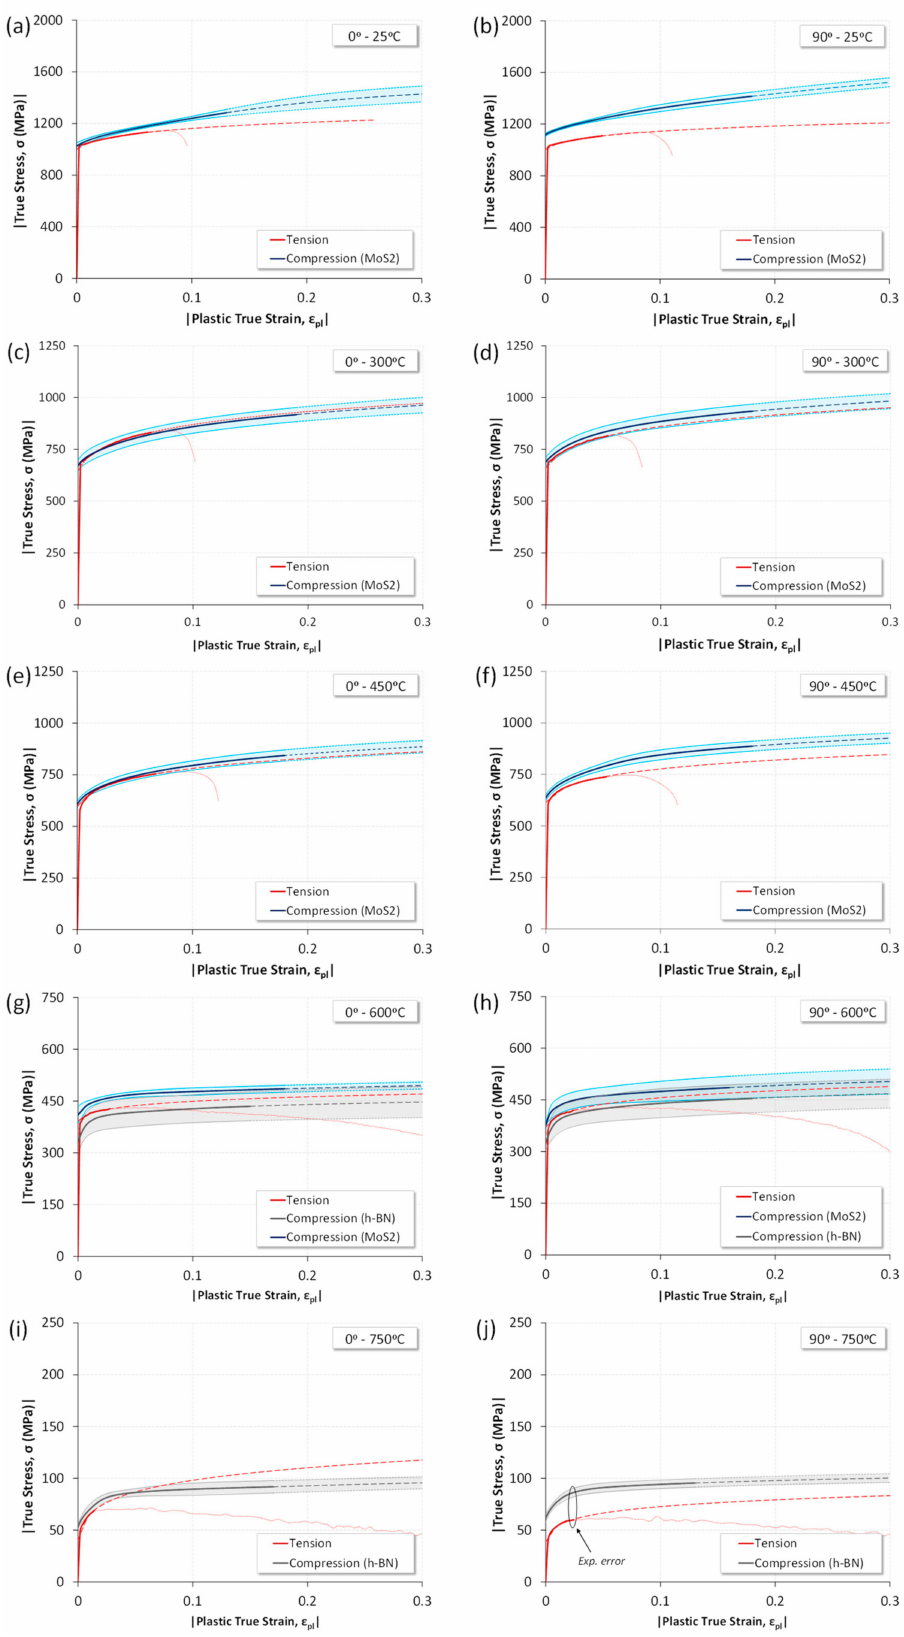
Figure 9. Tension and compression behavior of Ti6Al4V at 0.002 s − 1 and temperatures of 25, 300, 450, 600, and 750 ◦ C. ( a , c , e , g , i ) Mechanical behavior in rolling direction (0 ◦ ); ( b , d , f , h , j ) Mechanical behavior in transverse direction (90 ◦